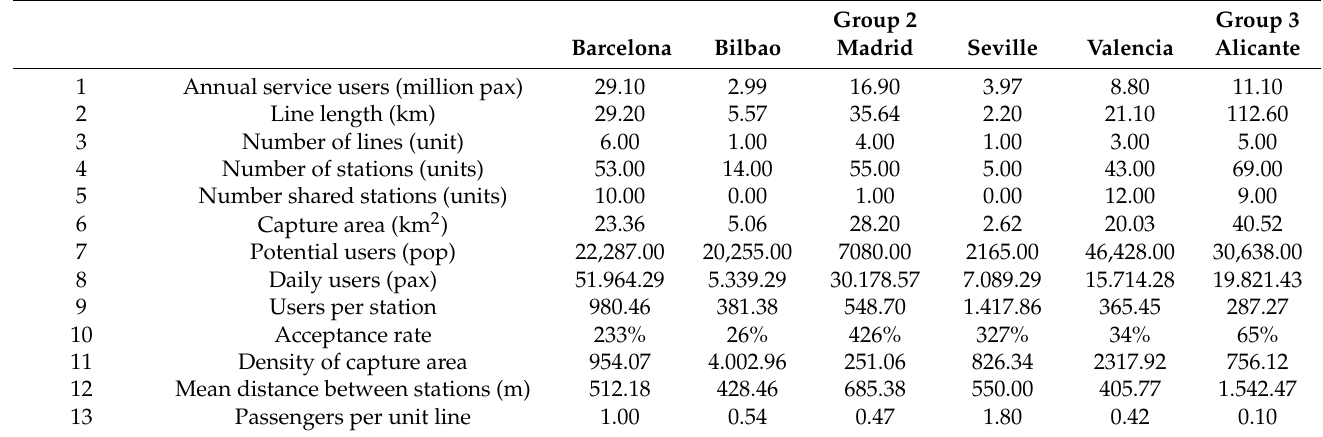
Table 4. Results for Groups 2 and